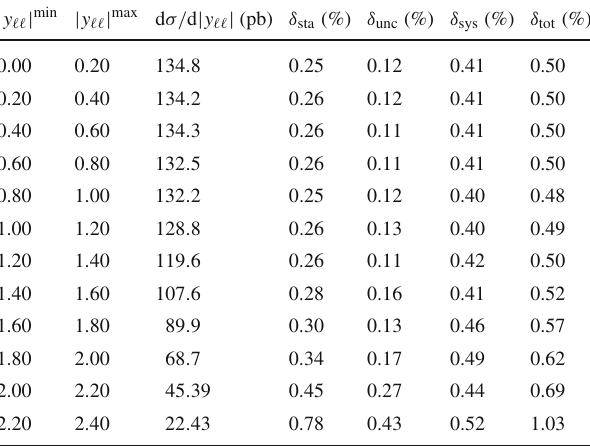
Table 28 Differential cross section for the Z /γ ∗ → μ + μ − process in the region with 66 < m (cid:3)(cid:3) < 116 GeV, extrapolated to the common fiducial region. The relative statistical ( δ sta ), uncorrelated systematic ( δ unc ),correlatedsystematic( δ sys ),andtotal( δ tot )uncertaintiesaregiven in percent. The overall 1 . 8% luminosity uncertainty is not included